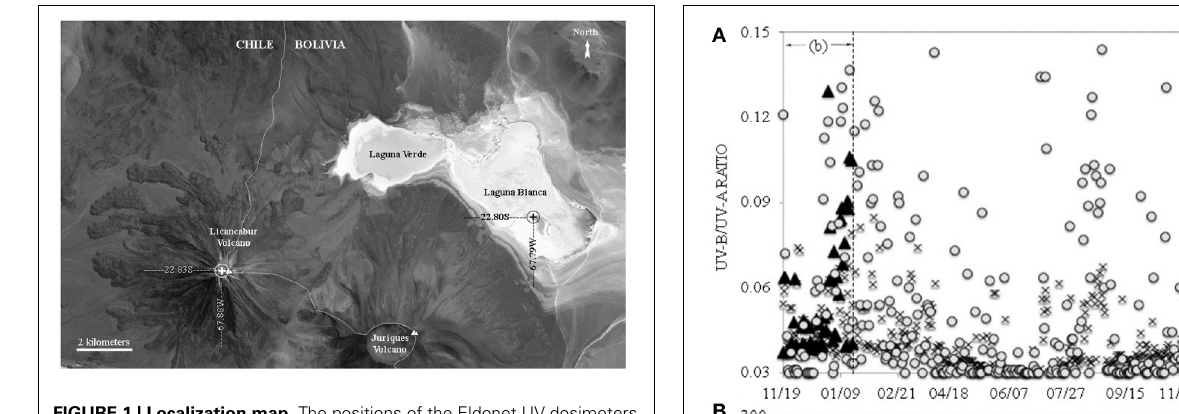
FIGURE 1 | Localization map. The positions of the Eldonet UV dosimeters are indicated by the white cross on top of the Licancabur volcano and the black cross on the peninsula of Laguna Blanca. ASTER image—Terra Satellite.